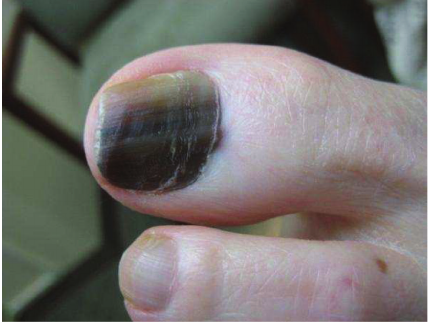
Figure 6: Nail apparatus melanoma in situ in a middle-aged Caucasian adult.